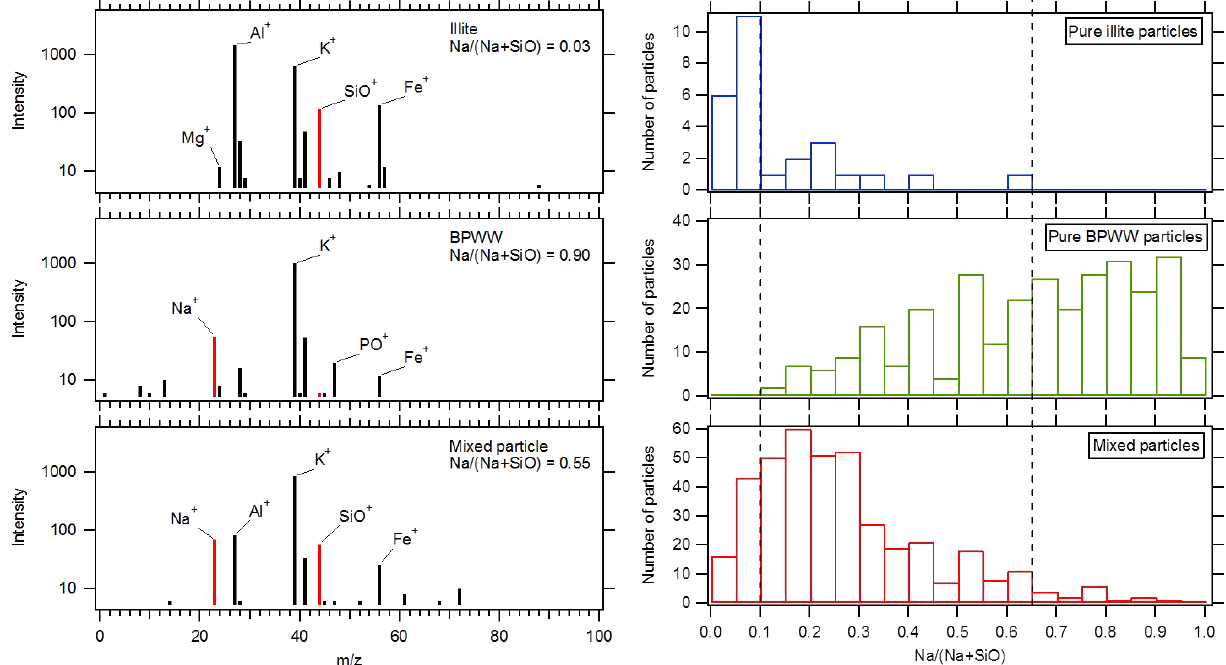
Figure 4. (left) Examples of single particle mass spectra of a pure illite particle, a pure BPWW particle, and a mixed particle. The marker peaks Na + ( m/z 23) and SiO + ( m/z 44) are highlighted. The values for Na /( Na + SiO) are given for each particle. (right) Histograms of the ratio (Na /( Na + SiO) for all particles. The dashed lines indicate the boundaries for pure illite ( < 0 . 1) and for pure BPWW ( > 0 .